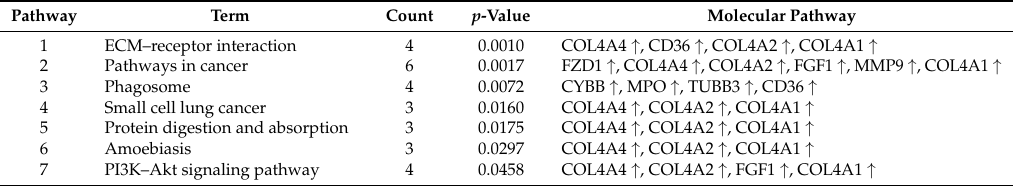
Figure 3. Gene Ontology (GO) analysis for differentially regulated proteins in the lung of PM 2.5 -exposed mice. The GO terms for cellular compartments ( A ), biological processes ( B ), and molecular functions ( C ) of the proteins are shown. Table 2. Kyoto Encyclopedia of Genes and Genomes (KEGG) pathway analysis of the differentially expressed proteins involved in PM 2.5 -induced pulmonary injury.